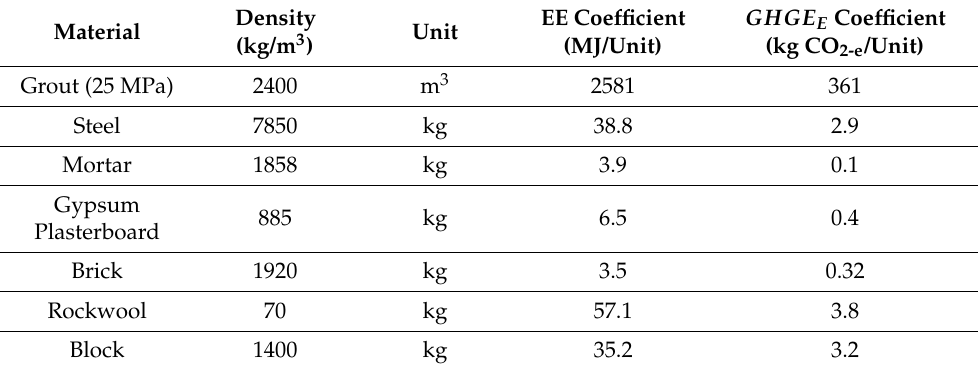
Table 4. The EE intensity, embodied greenhouse gas (GHGEE) intensity and density of construction material used in the wall systems